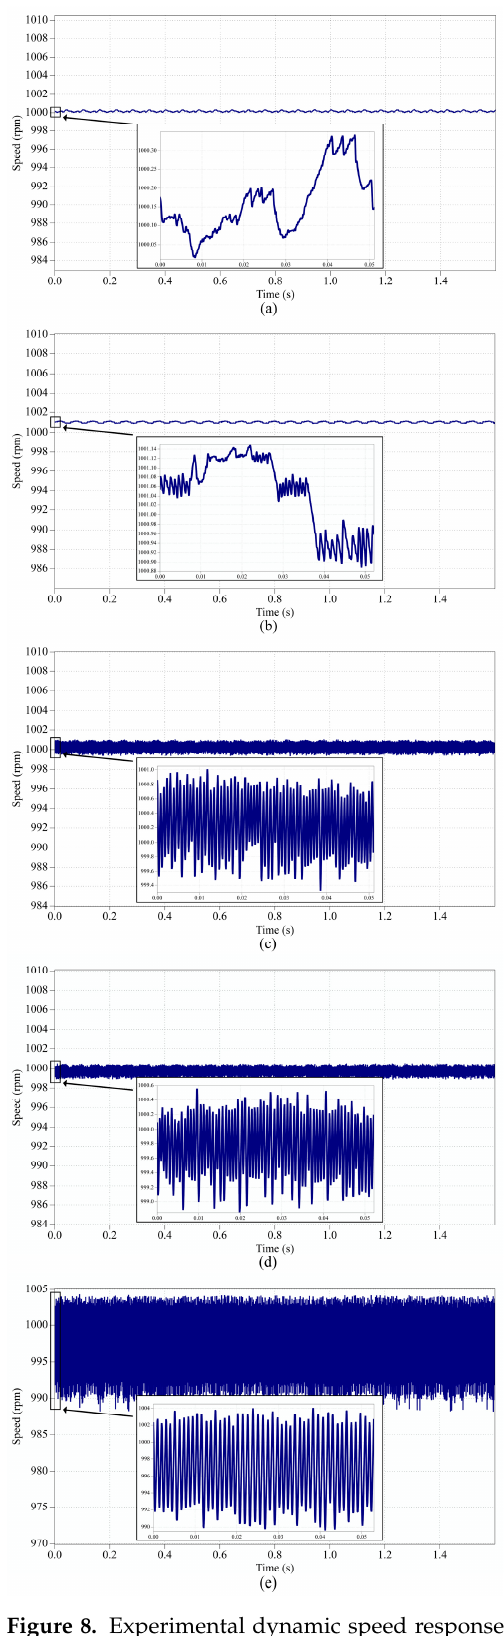
Figure 8. Experimental dynamic speed response of the PMSM under the no ‐ load condition and the step reference speed of 1000 rpm using HIL. ( a ) OLS ‐ FOSMC, ( b ) PR ‐ FOSMC, ( c ) RF ‐ FOSMC, ( d ) SVM ‐ FOSMC, ( e ) SMC.